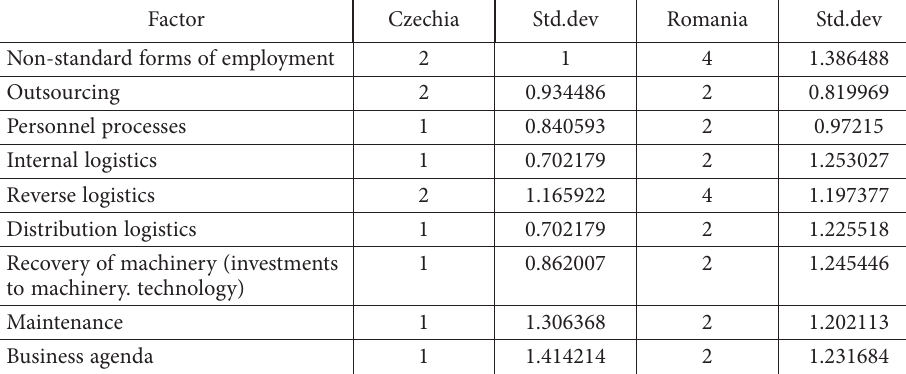
Table 7. Key processes – A student view (survey data mode values, differences are in bold)